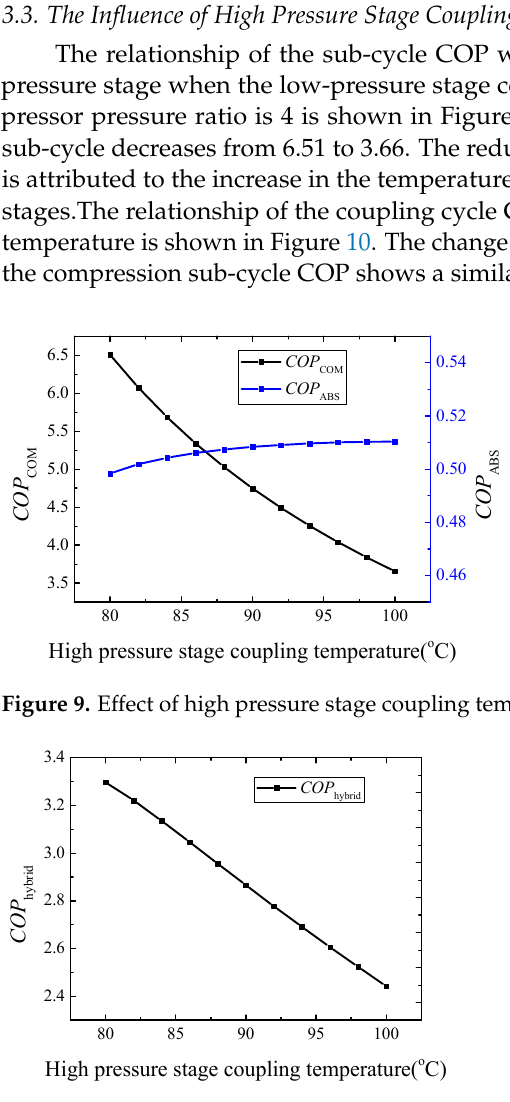
Figure 8. Effect of low pressure stage coupling temperature on the energy flow.